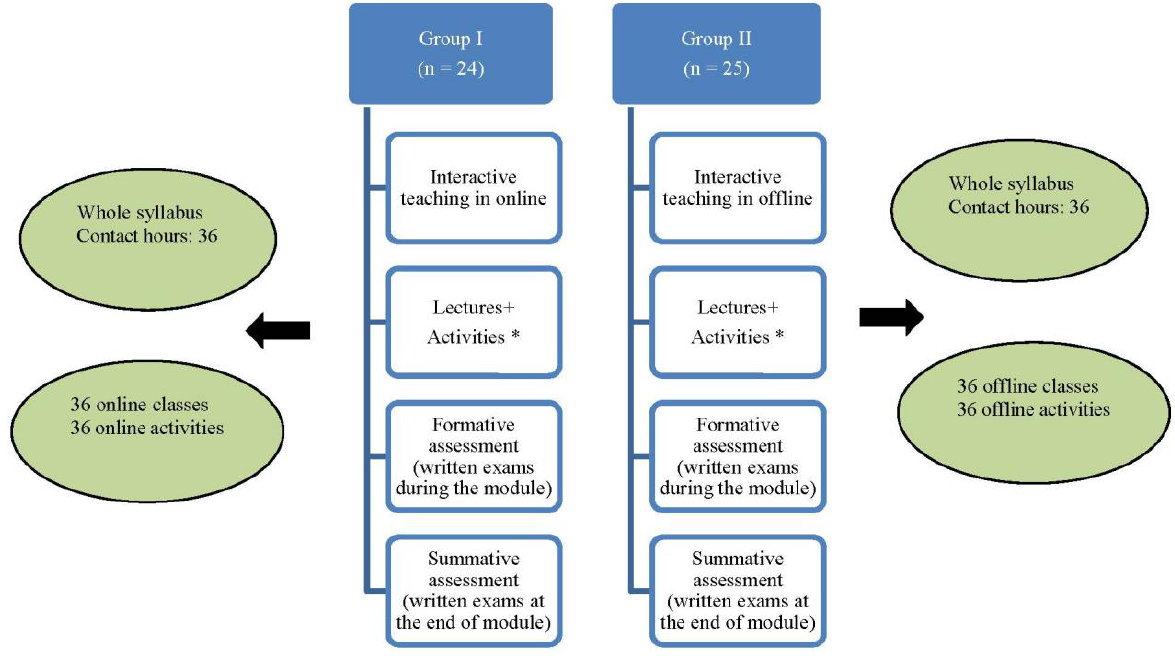
Figure 1. Schematic representation of interactive teaching in the online and offline platform. * 20 min lecture and 20 – 40 min activity from 8 a.m. – 3 p.m. for 1 week.